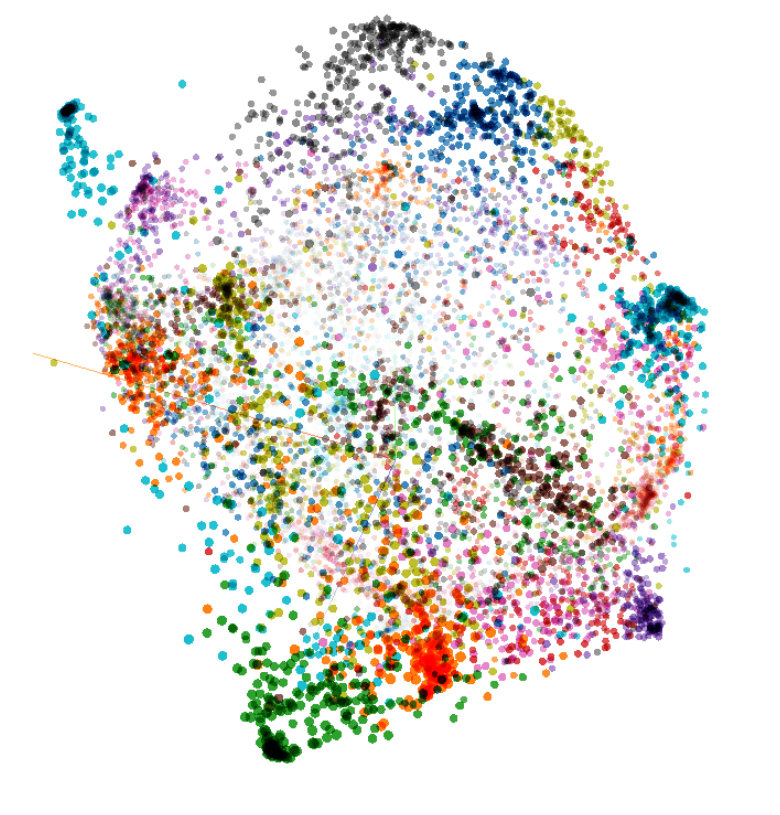
Figure A2. Distribution of all 53 hand gestures (labeled by colors) in the latent variable space.